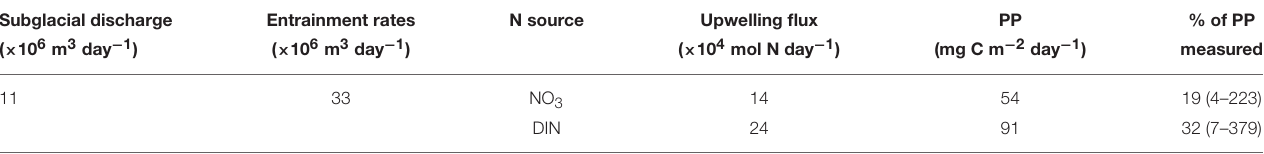
TABLE 3 | Potential primary production (PP) rates sustained by nutrient upwelling-induced by subglacial discharge at Kronebreen. Modelled entrainment rates relate to sampling of nutrients on 27 July 2017. For nitrate (NO 3 ) and dissolved inorganic nitrogen (DIN) concentrations, a mean of all Kronebreen stations at ≥ 50m water depth was converted to µ M carbon using the C:N ratio of 7.7 for Svalbard (Tamelander et al.,